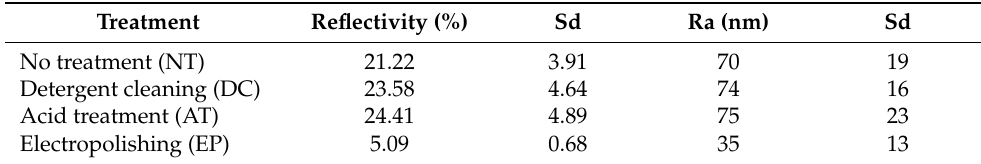
Table 2. Substrates average spectral reflectivity (%) and average roughness (Ra) according to the performed treatment.